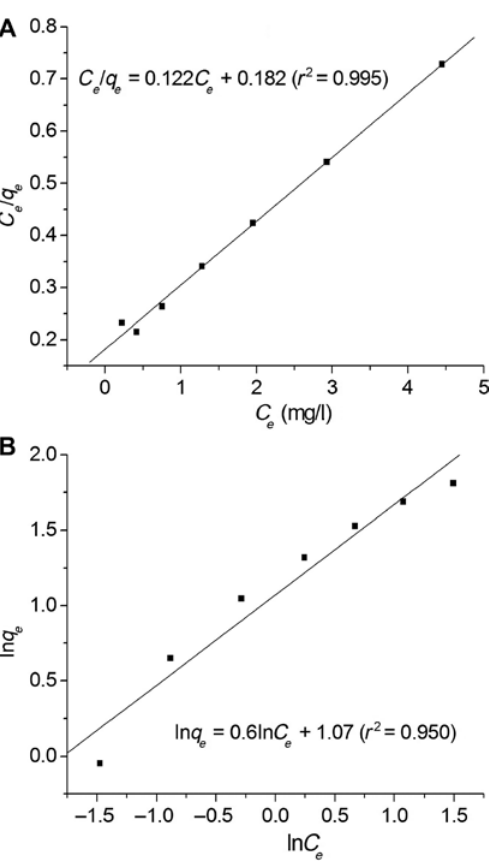
Figure 8: Linear form of Langmuir (A) and Freundlich (B) adsorption isotherm models.